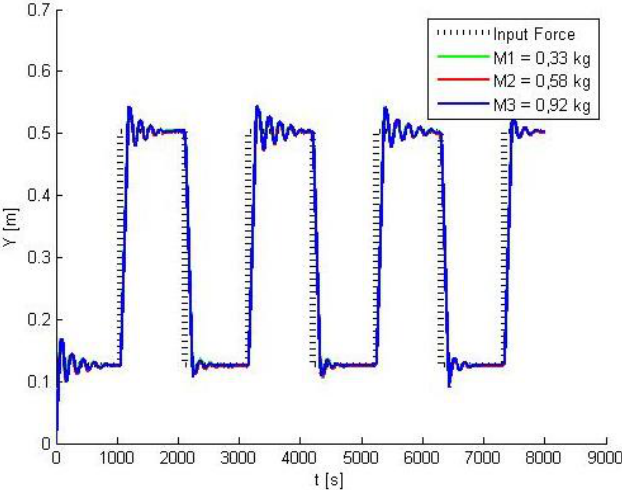
Fig. 8. Anti-swing 5DOF PI regulator Y -axis position simulation results.